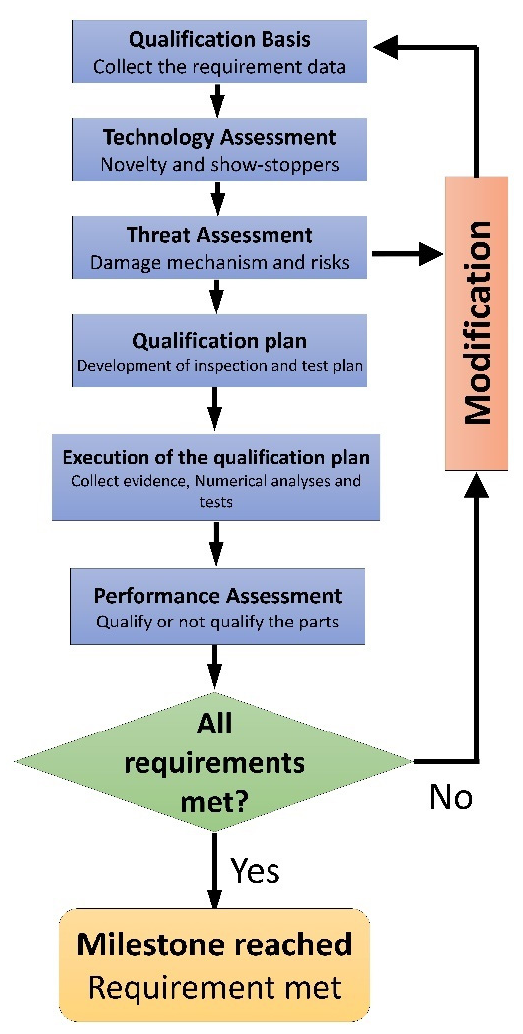
Figure 3. Risk-based qualification process.